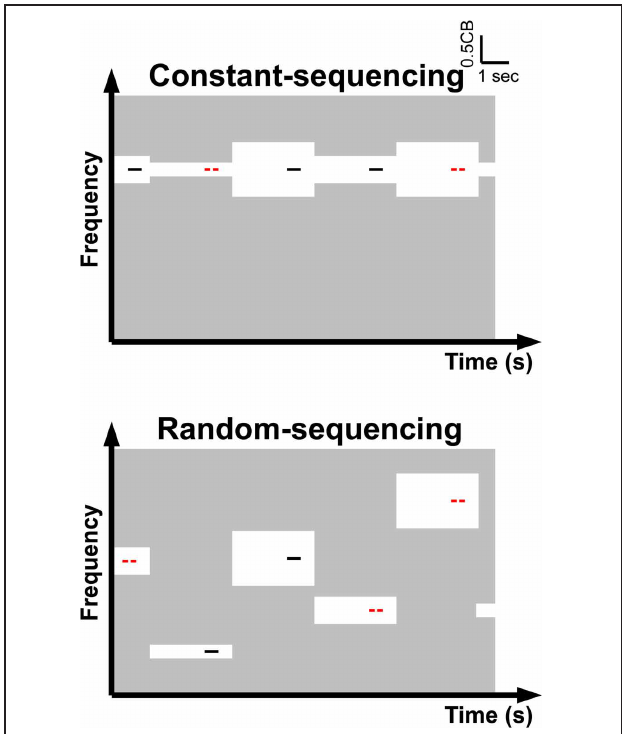
FIGURE 7 | ( Modified from Okamoto et al., 2009 ) Concept and time course of auditory stimulation in the constant sequencing and random sequencing conditions. Pass-bands and stop-bands of the band-eliminated noises (BENs) are represented by the light gray and white areas, respectively. The notch-bandwidth of a BEN (white area) is either 1/4, 1/2, or 1 critical band. Target and non-target test stimuli (TS) are represented as red lines with gap (target TS, requiring a button press) and black lines without gap (non-target TS), respectively. During the constant sequencing condition ( upper graph ), the TS is a series of identical frequencies, whereas during the random sequencing condition ( lower graph ) the TS has different frequencies. The TS frequencies differed between constant sequencing blocks. In total, identical bottom-up auditory inputs are provided during the constant sequencing and random sequencing